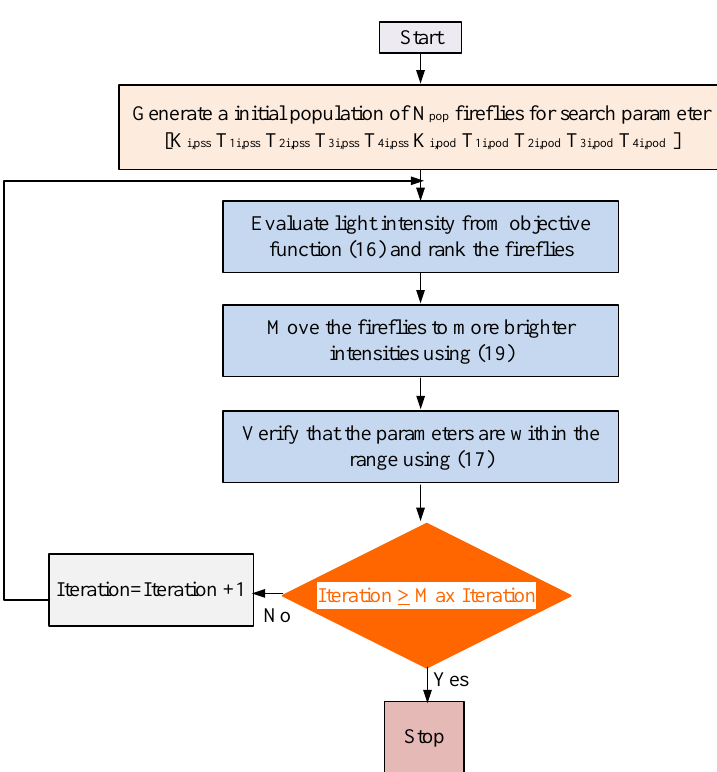
Figure 10. Flowchart of proposed method for optimal tuning of power-system controllers.